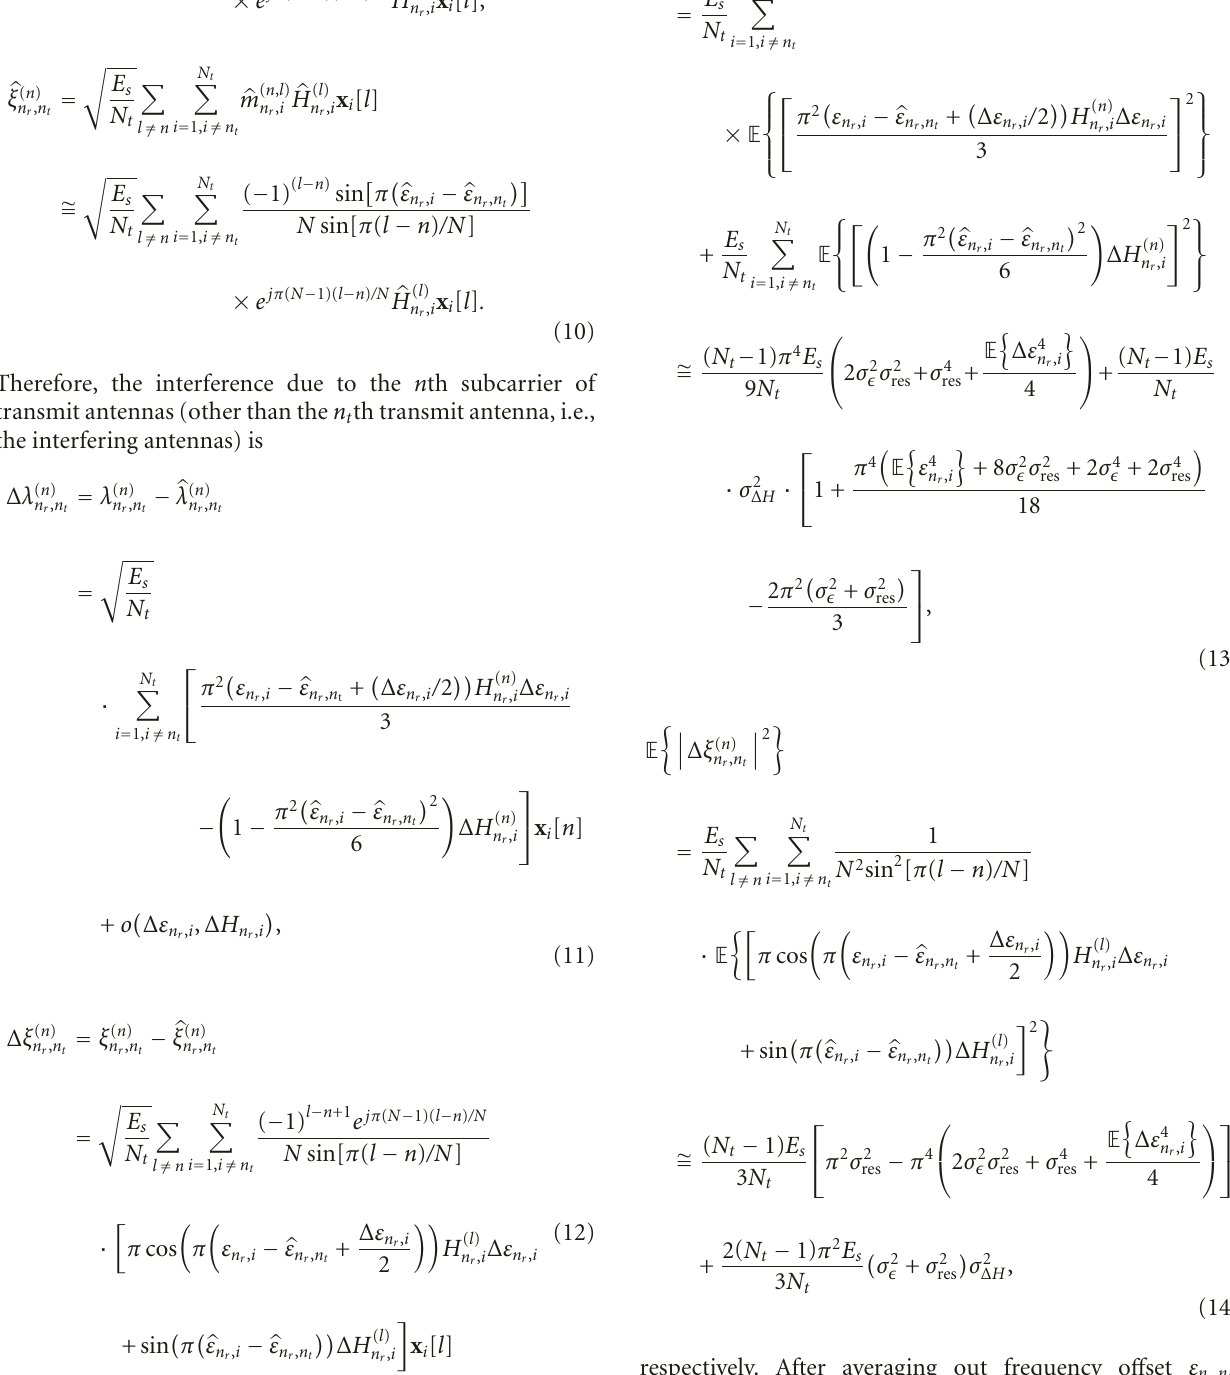
, r , n t , and channel estima- r , n t [ n r , n t